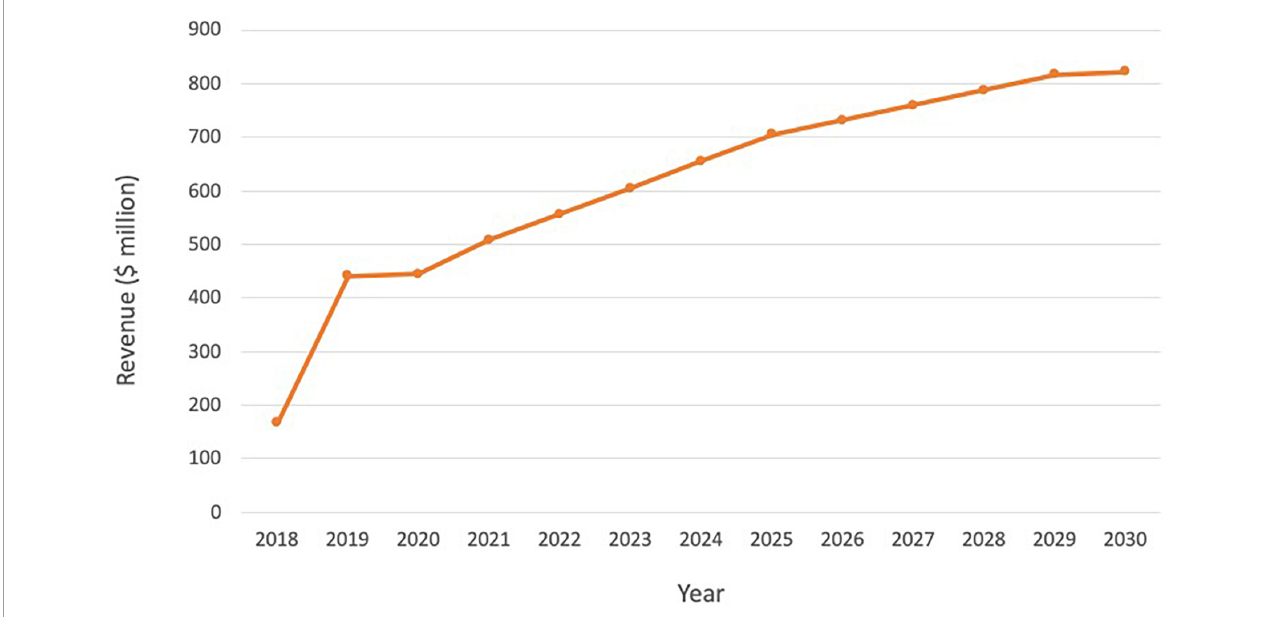
FIGURE4 Lutathera sales and projected sales for the period 2018–2030. Source: (51).